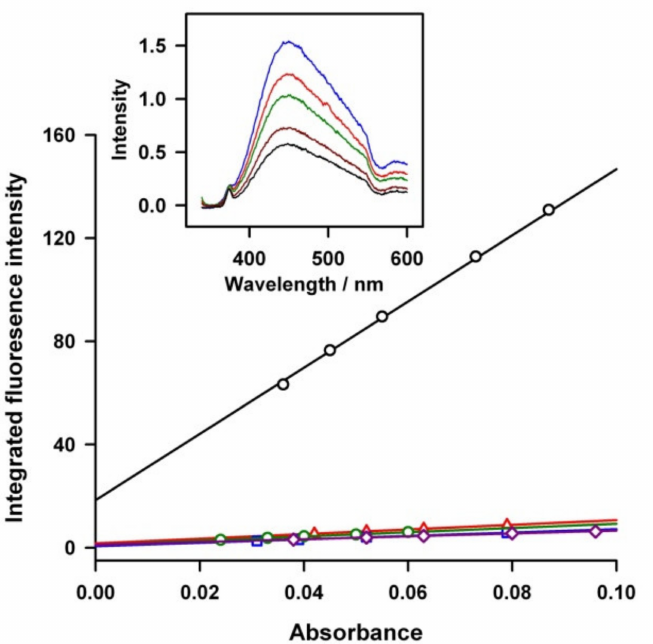
Figure 4. Plots of integrated photoluminescence intensity vs. absorbance of the various nanosized carbon particles, and quinine sulphate (black circle) (diluted samples). The red triangle, blue square, green circle, and purple diamond symbols are the CNPs of electro-exfoliated samples prepared at temperatures of 0 ◦ C, 20 ◦ C, 30 ◦ C, and 40 ◦ C, respectively. The inserted graph is a fluorescence emission spectra of CNPs (average diameter of 1 nm) with various dilution